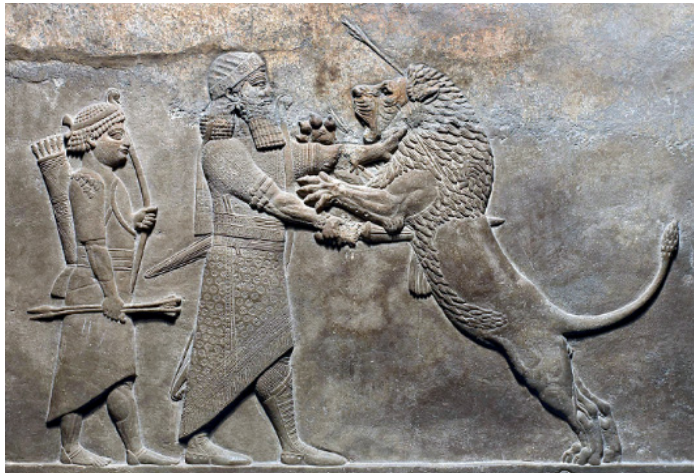
Figure 16. King Ashurbanipal on foot killing a lion with sword (BM inv. no. 124874; reg. no. 1856,0909.48); gypsum relief; North Palace, Nineveh (mod. Iraq); Neo-Assyrian, ca. 645–635 BCE [image courtesy of the Trustees of the British Museum, London].